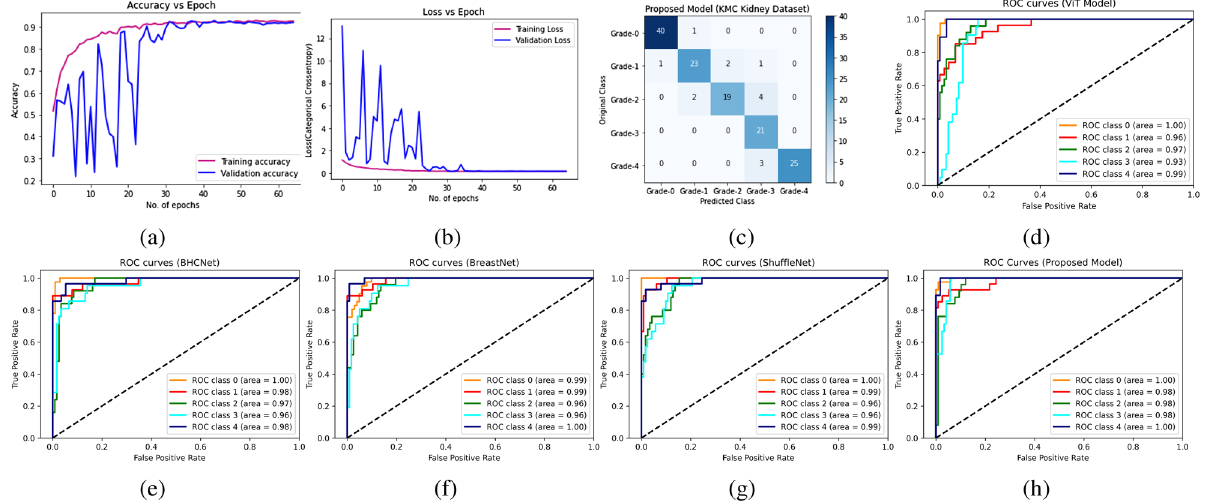
Figure 4. Learning curve of RCCGNet on intoduced KMC kidney dataset. ( a ) Training and validation accuracy of proposed model. ( b ) Training and validation loss of proposed model. ( c ) Confusion matrix of proposed model. ( d – h ) Receiver operating characteristic (ROC) curve of five best-performing state-of-the-art models using one versus rest approach.